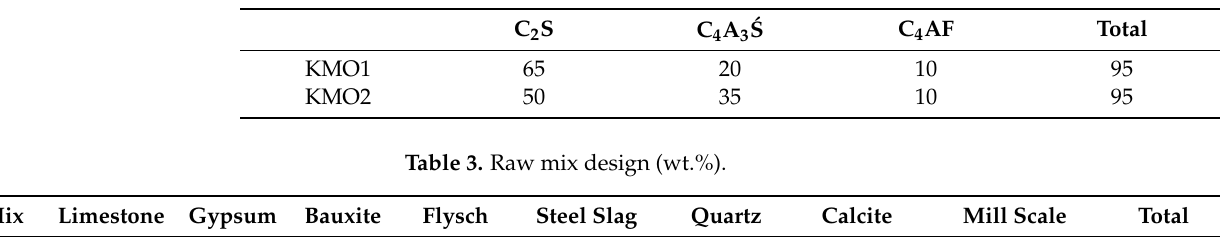
Table 2. Intended phase compositions of the raw mixtures KMO1 and KMO2 (wt.%).